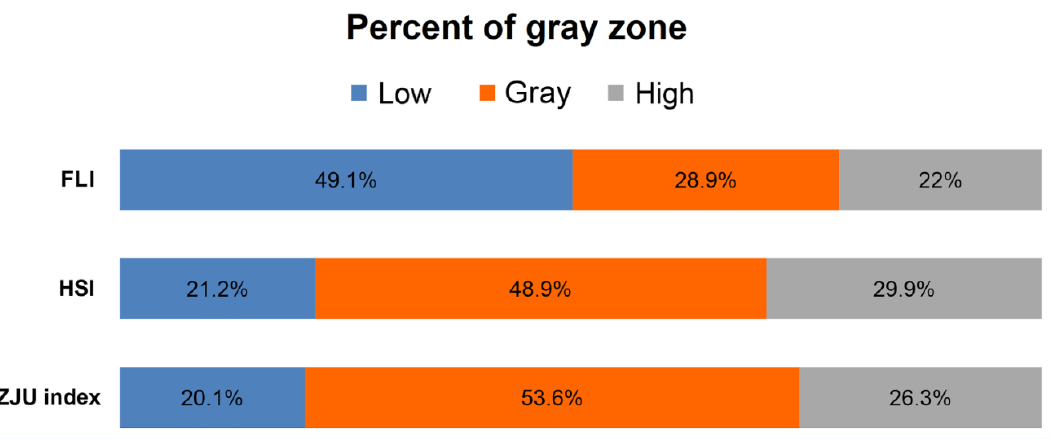
Figure 5. Proportions of gray zones among estimated formulae using two cutoffs.